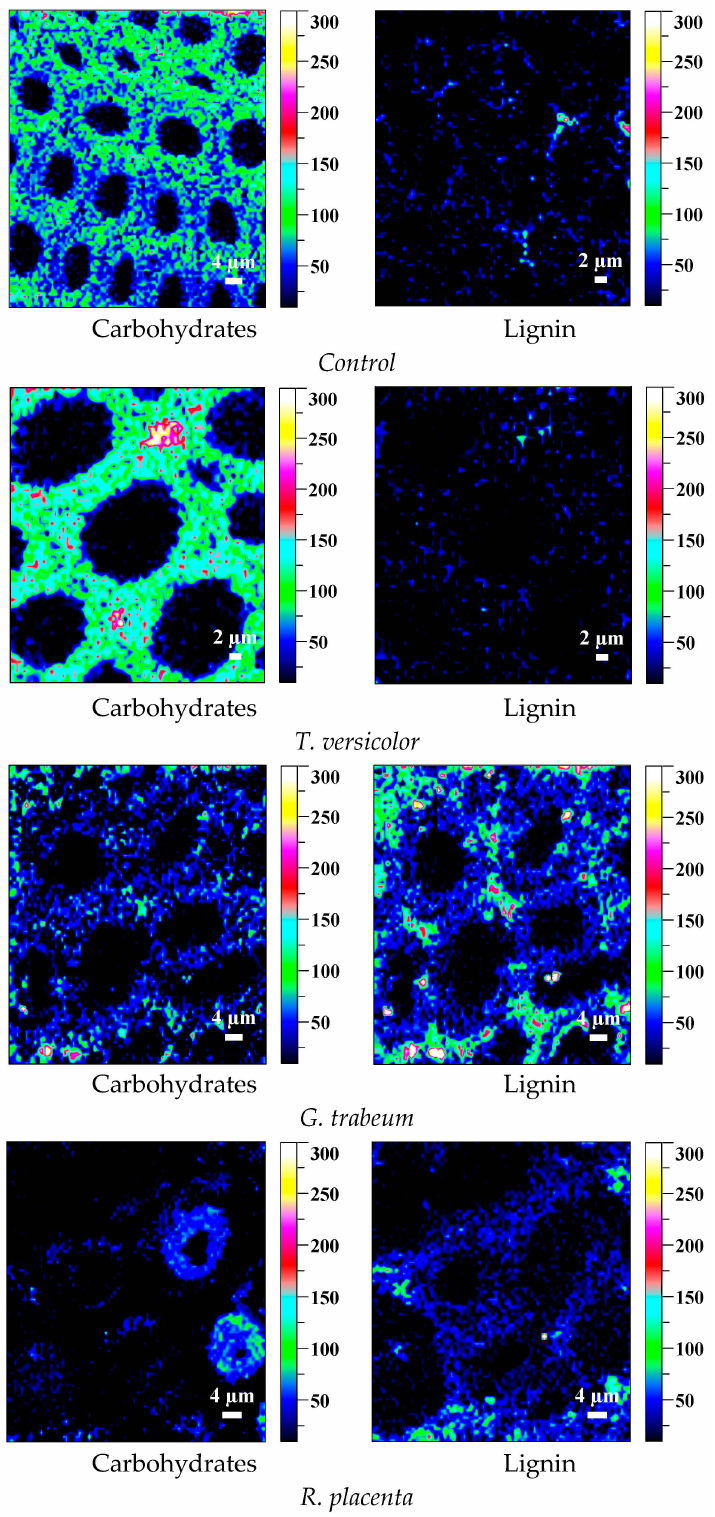
Figure 7. Raman images of Hevea brasiliensis samples converted by different fungi for 16 weeks. Microstructure observation showed that the hyphae of decay fungi colonized and spread in the lumina of the wood cells, and caused the greater disruption of the integrity within the cell walls, which created large pores and could facilitate the enzymatic